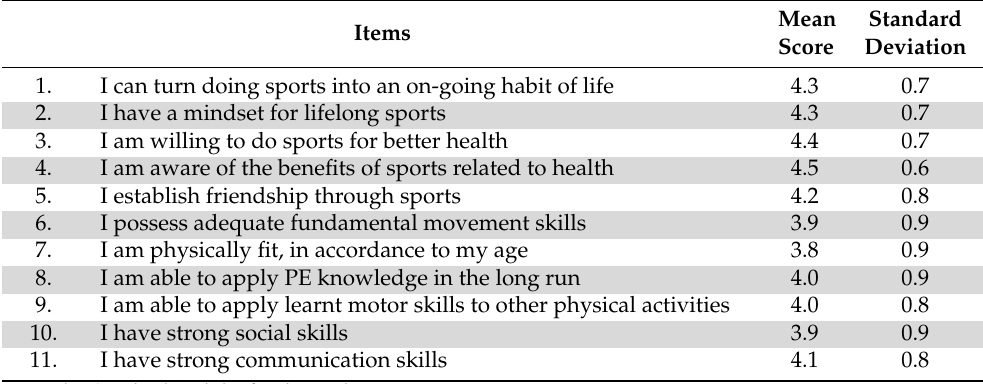
Table 5. Senior Perceived Physical Literacy Instrument and the item response